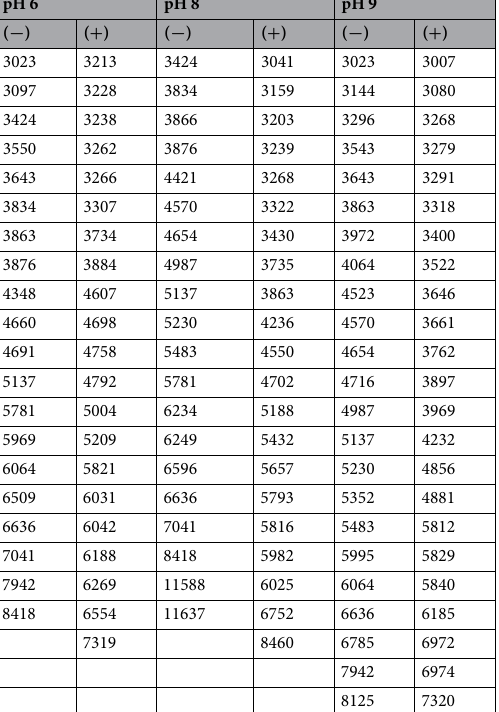
Table 1. Summarizes of signals observed on MALDI-TOF MS spectra (Fig. 4), where ( − ) mean disappearance of signal in comparison to control and ( + ) mean appearance of signal in comparison to the overexpression of cell wall integrity regulators as a response to the osmotic and ionic changes that occur in the media 29 which can explain the changes of protein profiles observed in this work during MALDI TOF/MS analysis. Observed signals at specific m/z value can be assigned to presence of specific proteins occurring in yeast cells. According to the UniProt database, the disappearance of signals at 6636 m/z after the yeast incubation with